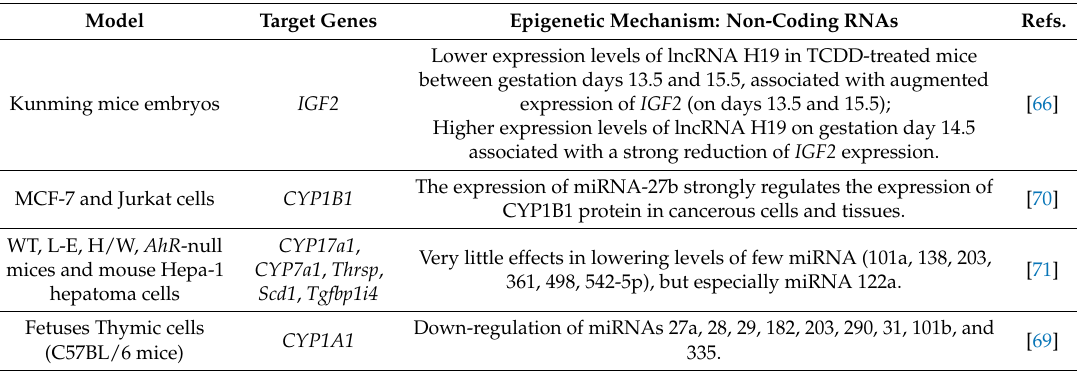
Table 3. Summary of the recent papers dealing with new insights in the role of ncRNAs in mediating TCDD toxicity. Target Genes Epigenetic Mechanism: Non-Coding RNAs Refs. Lower expression levels of lncRNA H19 in TCDD-treated mice between gestation days 13.5 and 15.5, associated with augmented IGF2 expression of IGF2 (on days 13.5 and 15.5); Higher expression levels of lncRNA H19 on gestation day 14.5 associated with a strong reduction of IGF2 expression. The expression of miRNA-27b strongly regulates the expression of CYP1B1 protein in cancerous cells and